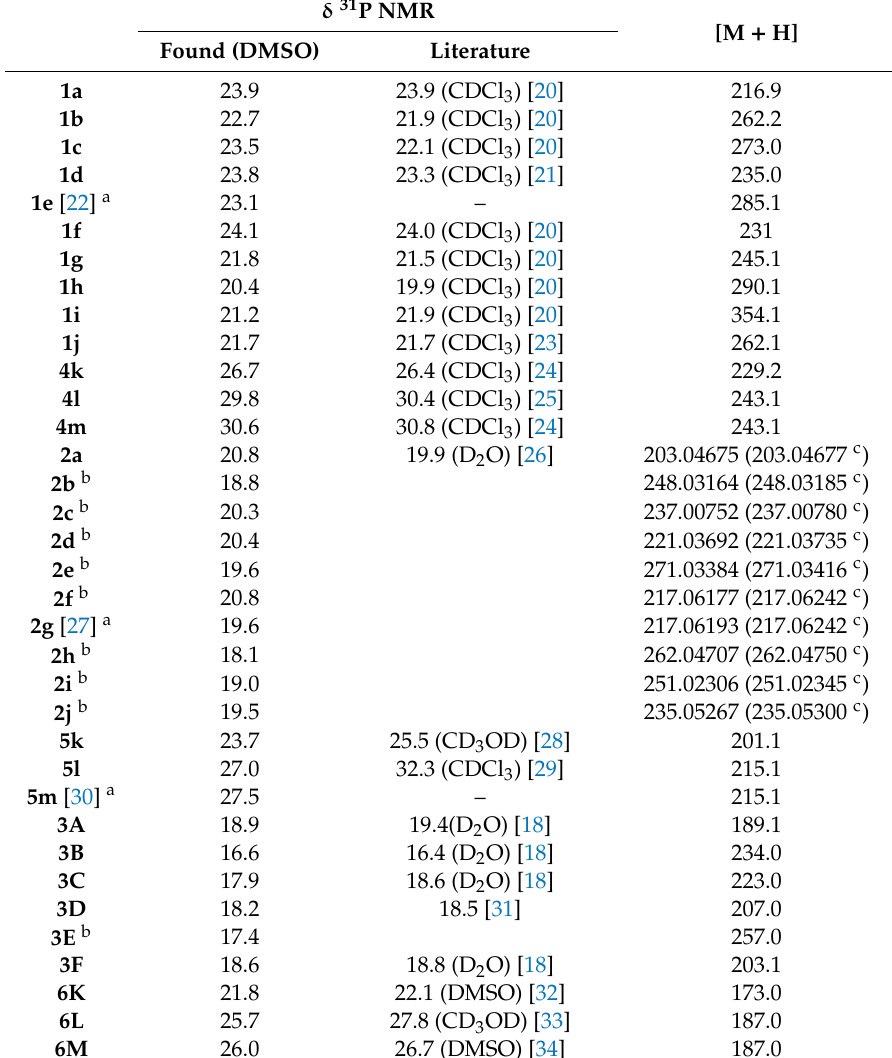
Table 4. Identification of the starting phosphonates ( 1a – j , 4k – m ), ester–acid intermediates ( 2a – j , 5k – m ), and phosphonic acids ( 3A – F , 6K – M